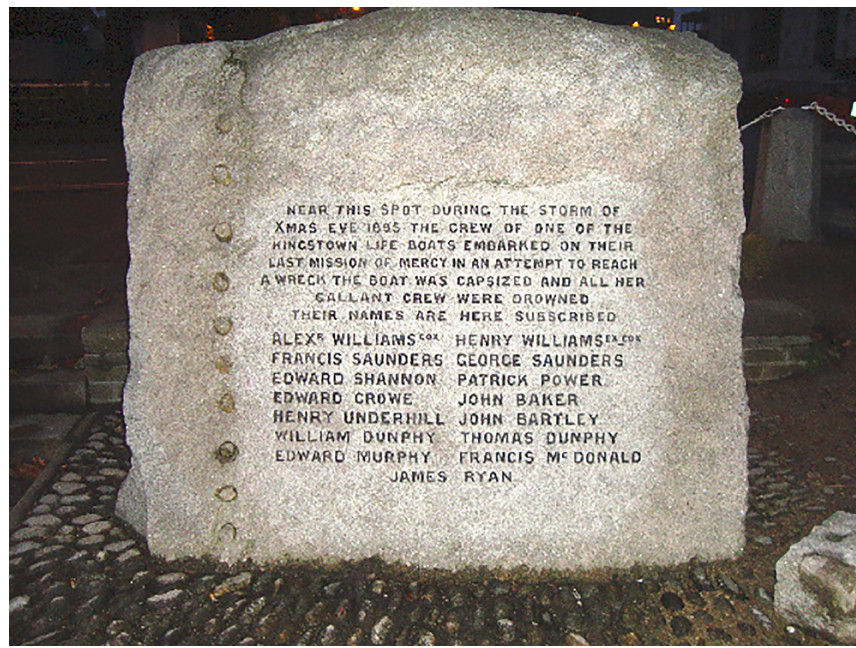
Figure 5. Granite memorial on the old lifeboat station wall, Dun Laoghaire (Hohenloh,